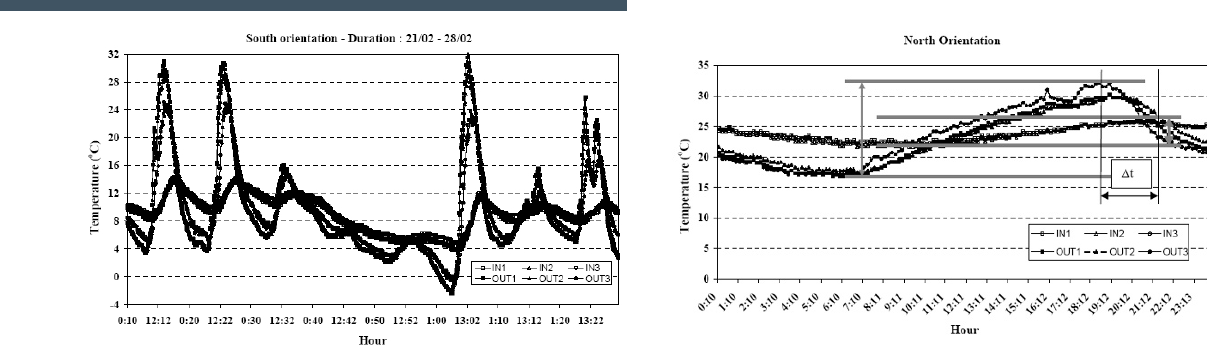
Figure 9. Temperature distribution inside and outside at south wall in February Winter period .